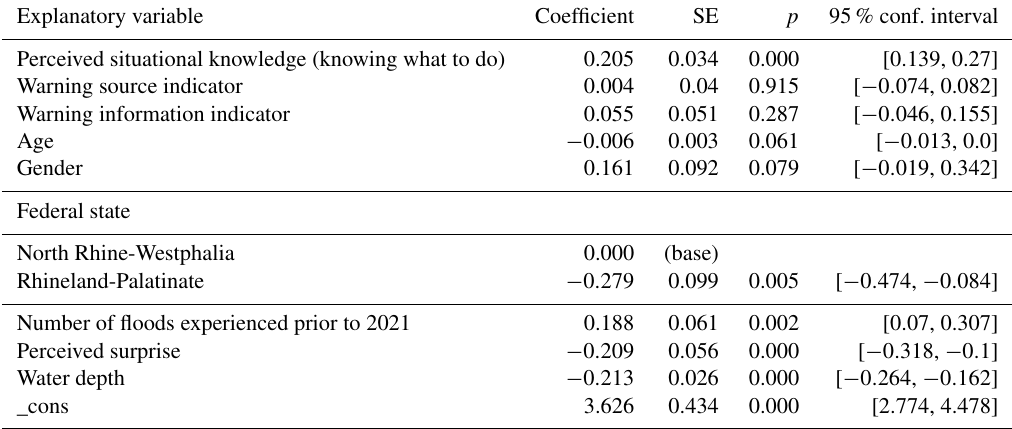
Table 5. Results of the linear regression model predicting respondents’ perceived damage reduction due to risk-reducing behaviour ( n = 1003). All variable definitions, coding and summary statistics are provided in the Supplement, Table